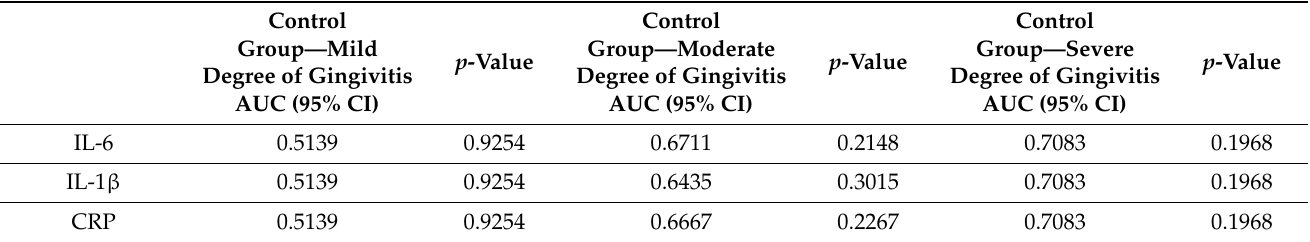
Table 4. ROC logistic regression analysis of salivary IL-6, IL-1 β , and CRP levels comparing the control group with the groups with mild, moderate, and severe degrees of plaque-induced